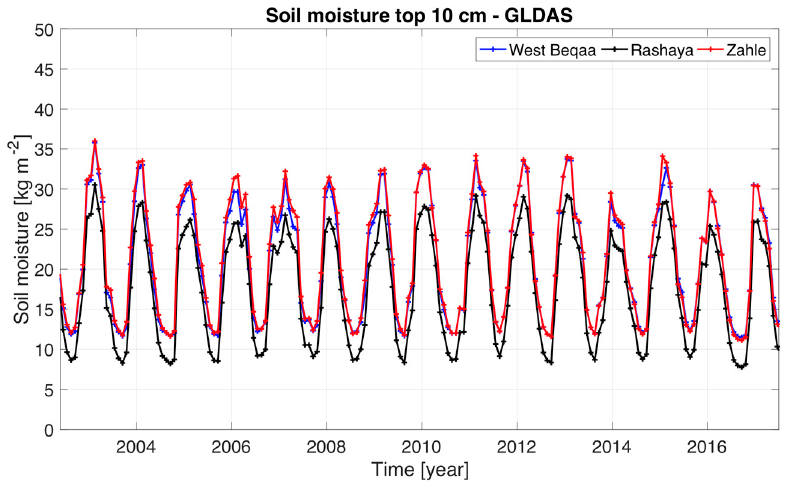
Figure 3. Soil Moisture storage in the top 10 cm (SM) from the Global Land Data Assimilation System (GLDAS) model simulations. Three separate regions are shown.